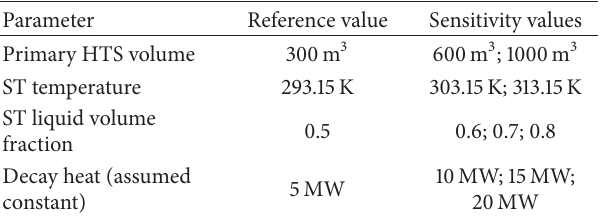
Table 1: Reference and sensitivity values in the parametric analyses.